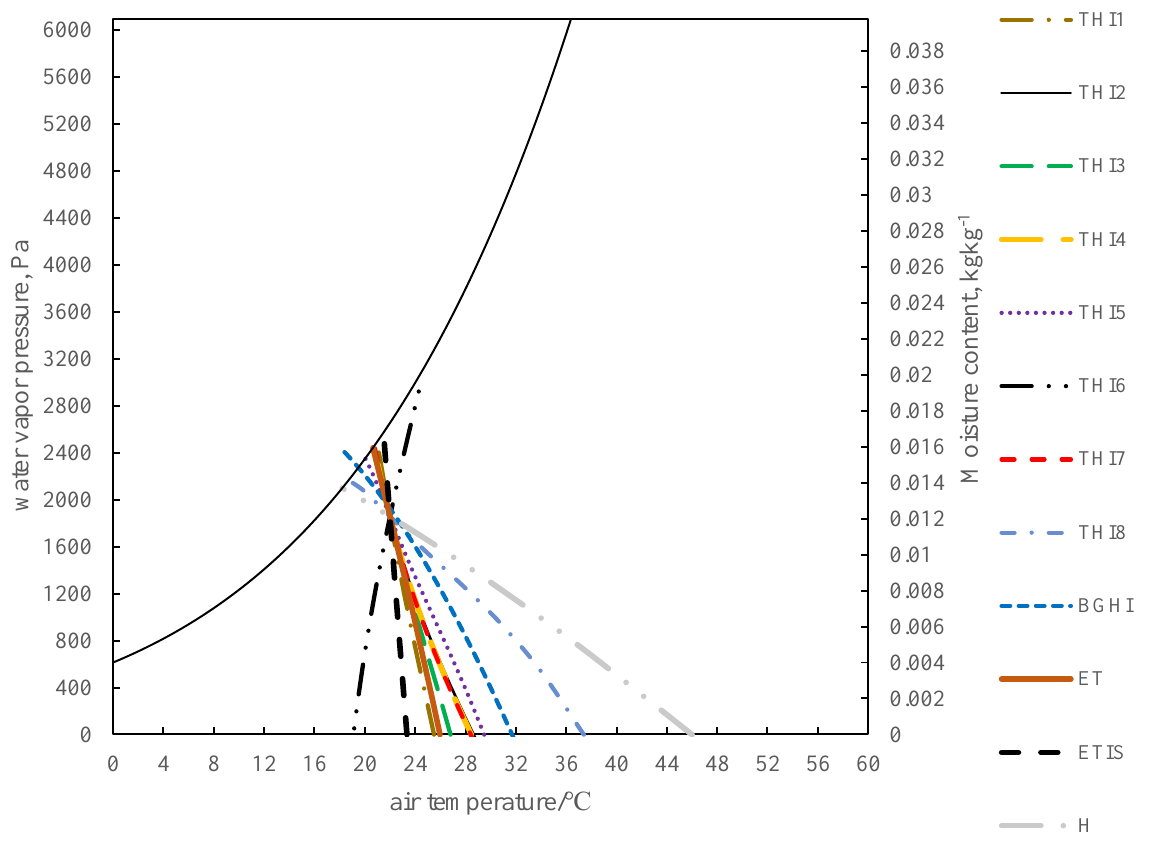
Figure 4. The patterns of the thermal indices in the psychrometric chart. All heat indices are consistent with the heat index value when the air temperature is 22 °C and the relative humidity is 70%. In this way, the iso-index lines of various heat indices are drawn. When compared with other thermal indices, the air velocity of effective temperature and equivalent temperature index of sows is taken as 0 m · s − 1 . THI is the temperature and humidity index. The numbers 1–8 after THI represent different forms of THI, which are shown in Table 1. BGHI is black globe-humidity index. ET is effective temperature, ETIS is equivalent temperature index of sows. H is enthalpy.